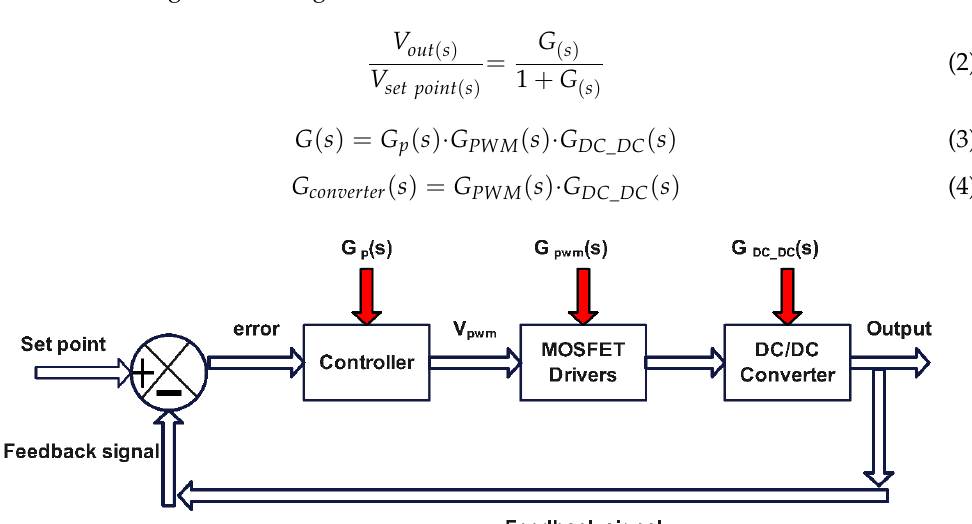
Figure 4. System block diagram with feedback control.